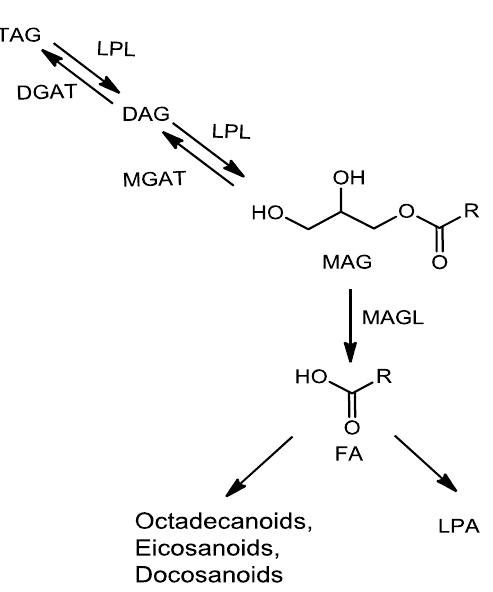
Figure 1. Biological pathways of monoacylglycerol (MAG). LPL, lipoprotein lipase; DGAT, diacylglycerol acyltransferase; MGAT, monoacylglycerol acyltransferase; MAGL, monoacylglycerol lipase; DAG, diacylglycerol; TAG, triacylglycerol; LPA, lysophosphatidyl acid; FA, fatty acid.